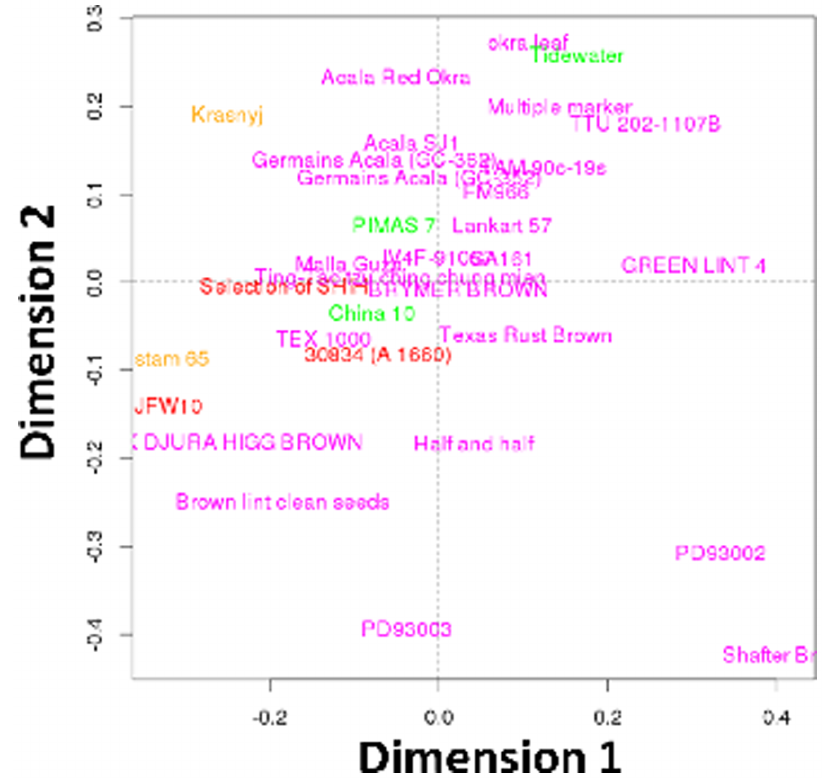
Figure 3. Graphical representation of the cotton lines on the first two sPLS dimensions shows the trend in clustering of specific cotton lines across different species. Four different species of cotton are shown in different colors. Gossypium hirsutum is colored in magenta, Gossypium barbadense in green, Gossypium herbaceum in orange and Gossypium arboreum in red.